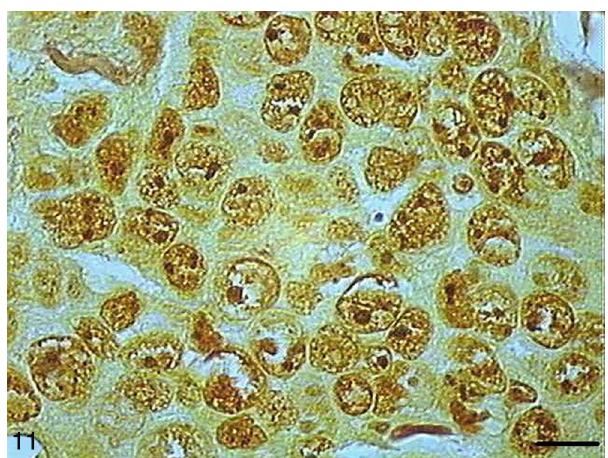
Figure 11 Grade III squamous carcinoma cells with AgNORs. Micrograph of grade III squamous carcinoma cells with AgNORs forming dark clumps together and occupying the entire nucle- olus or isolated as small satellites in large nuclei (AgNOR, bar = 10 (cid:2) m).